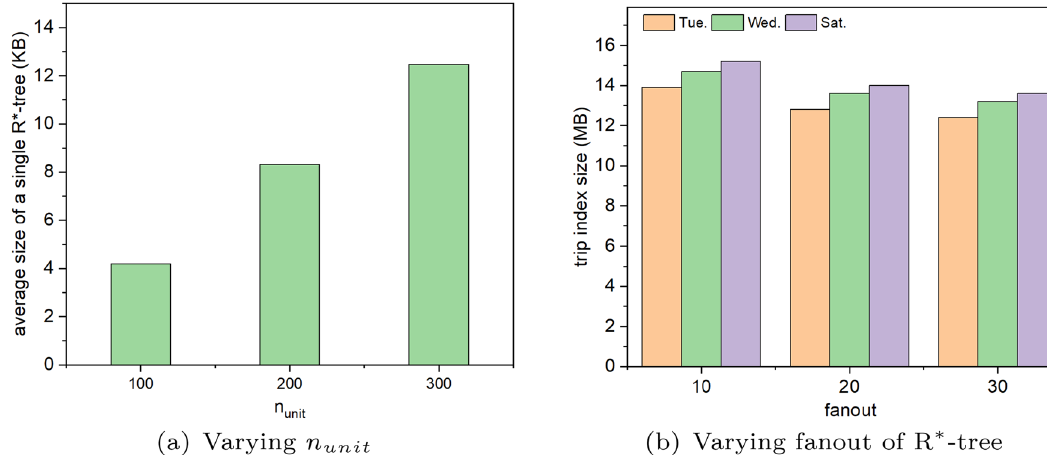
Fig. 15 The index sizes w.r.t. different parameter